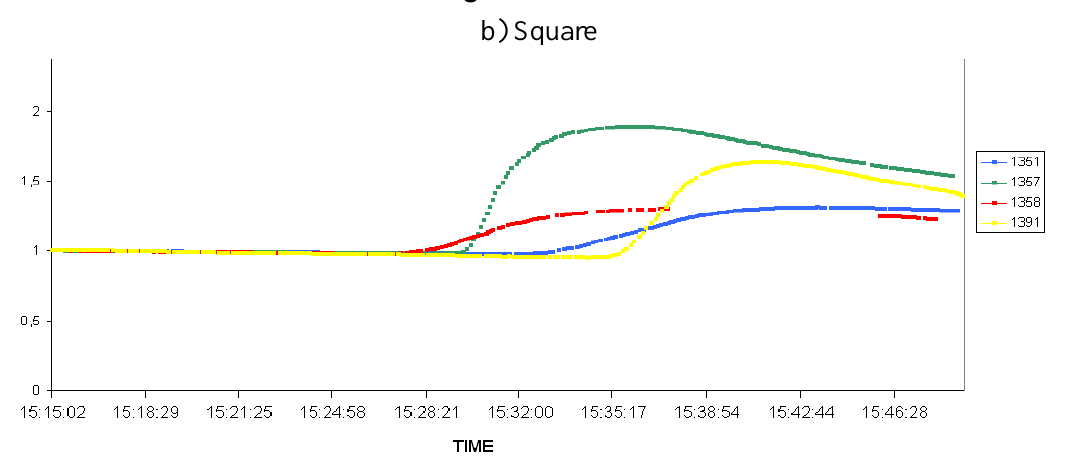
Figure 10. Cont. b)